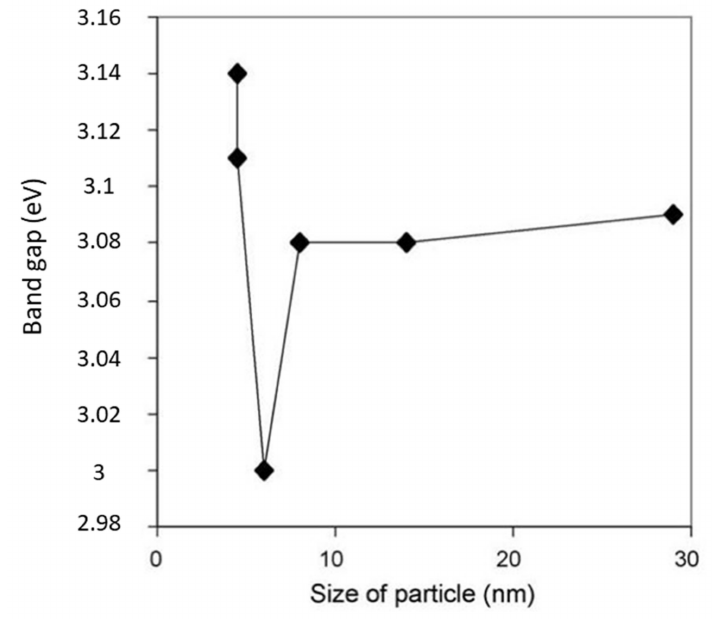
Figure 20. Effect of particle size on band gap. Reprinted with permission from Elsevier, 21 December 2021 Ref. [84].